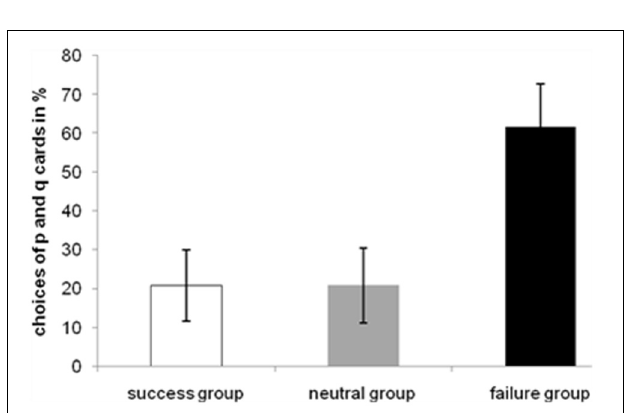
FIGURE 4 | Choices of the p and q cards of the WSTs in relative frequencies (%) for each group. With p and q (modus ponens) participants tried to confirm the